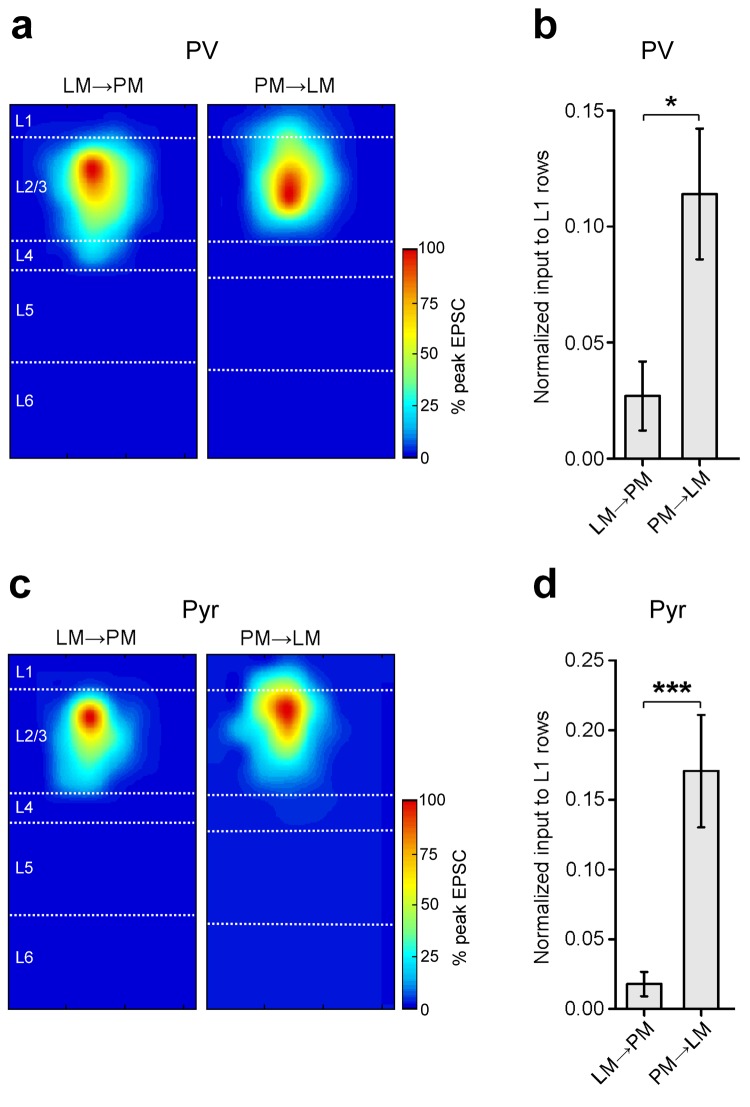
Stronger input to L1 in the PM-to-LM than in the LM-to-PM pathway.(a) Normalized heat maps of average EPSCs in L2/3 PV cells in the FFLM→PM and FBPM→LM pathways. EPSC values normalized to peak pixel in each panel. (b) Interareal input to L1 is stronger for PV cells in the FBPM→LM pathway than in FFLM→PM. L1 input calculated as average input to each row of the 8 × 16 grid that resided in L1, normalized to total EPSC recorded from the cell. (c) Normalized heat maps of average EPSCs in L2/3 Pyr cells in FFLM→PM and FBPM→LM. EPSC values normalized to peak value within panel. (d) Interareal input to L1 is stronger for Pyr cells in the FBPM→LM than in the FFLM→PM pathway.